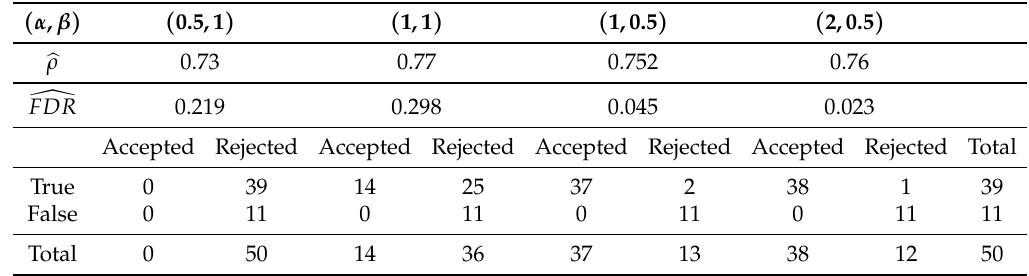
Table 1. Results for the model with Gaussian copulas and for data corresponding to 80% of true null hypotheses to distinct values of the prior distributions of p i